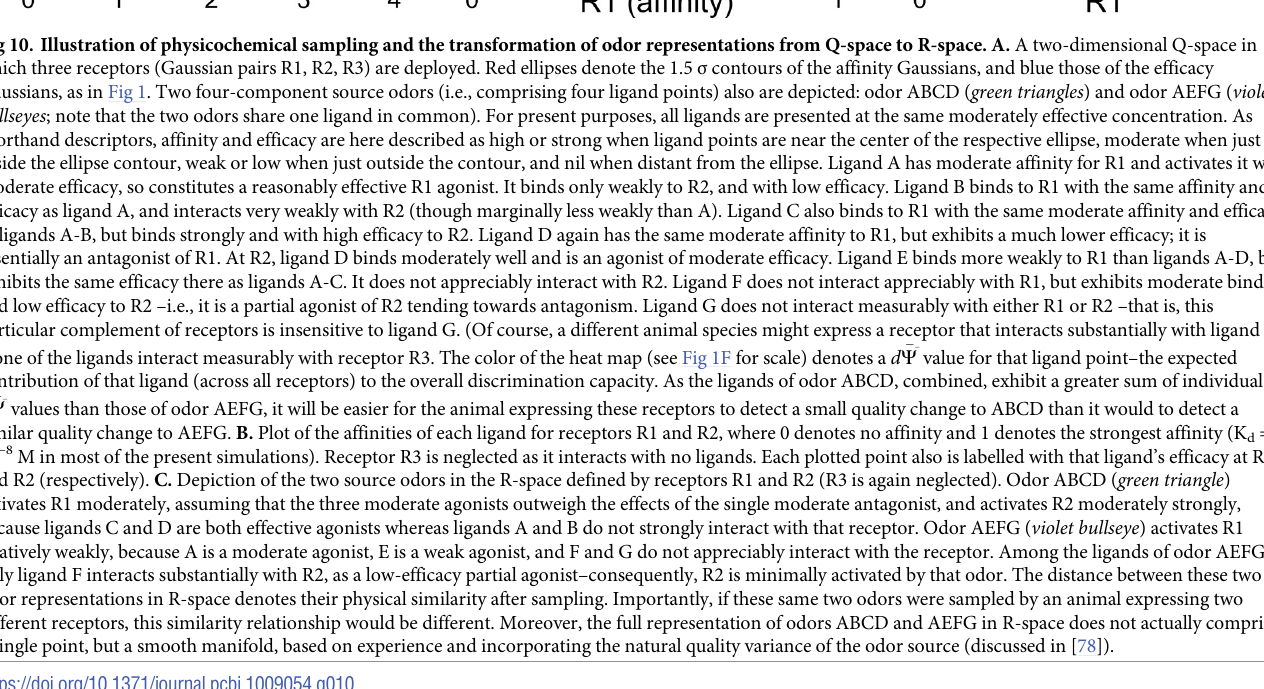
PLOS Computational Biology | https://doi.org/10.1371/journal.pcbi.1009054 June 11,